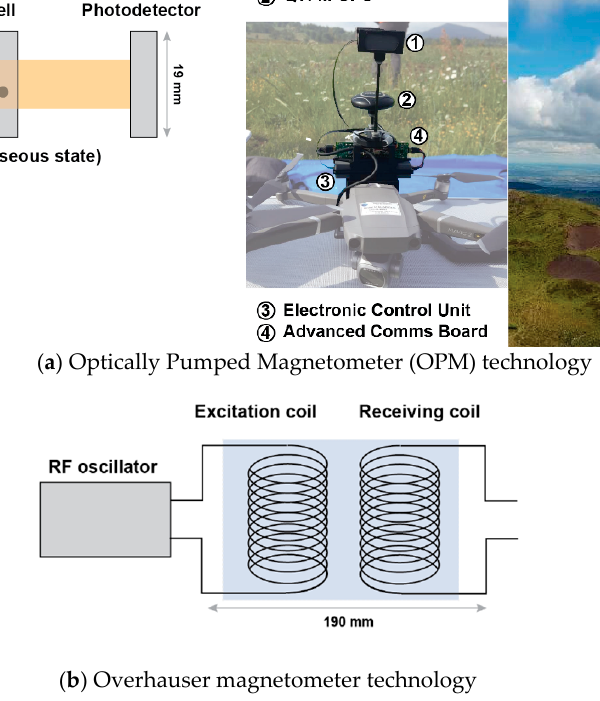
Figure 2. ( a ) QuSpin Total Field (QTFM) magnetic sensor (mounted on a DJI Mavic Pro2) and ( b ) GSM 19 (GEM system) ground magnetometer, both deployed in the field (petit Puy de Dôme volcano). Simplified diagrams of the Optically Pumped Magnetometer (OPM, © QUSPIN) and the Overhauser technology are shown above and below the photos.